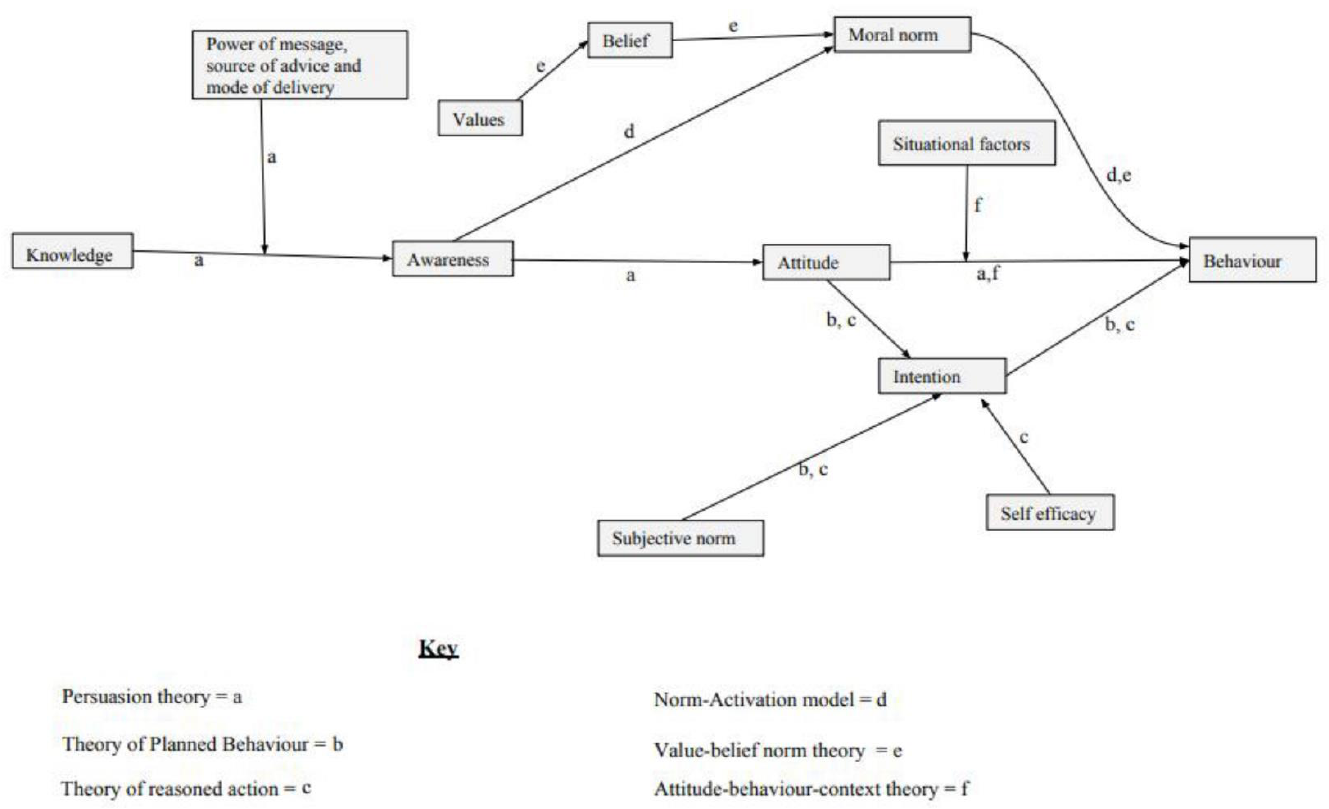
Figure 1. Integrated Framework of the behavioural theories to aid understanding of pro-environmental behaviour. Note: We use letters to represent the different pathways (e.g., knowledge-awareness link, awareness-behaviour link, knowledge-behaviour link) hypothesised in each of the theories.